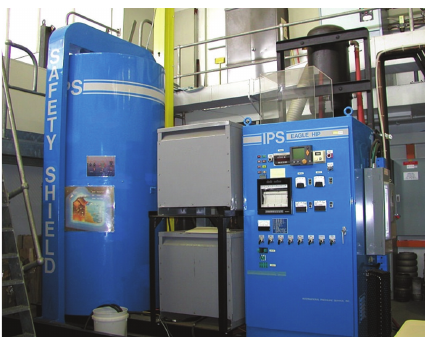
Figure 2: A hot Isostatic press located at ANSTO. This press can take up to a 30 cm diameter load. The machine consists of a pressure vessel in which a furnace is installed. Densification occurs under Ar at up to 200 MPa at the desired temperature.